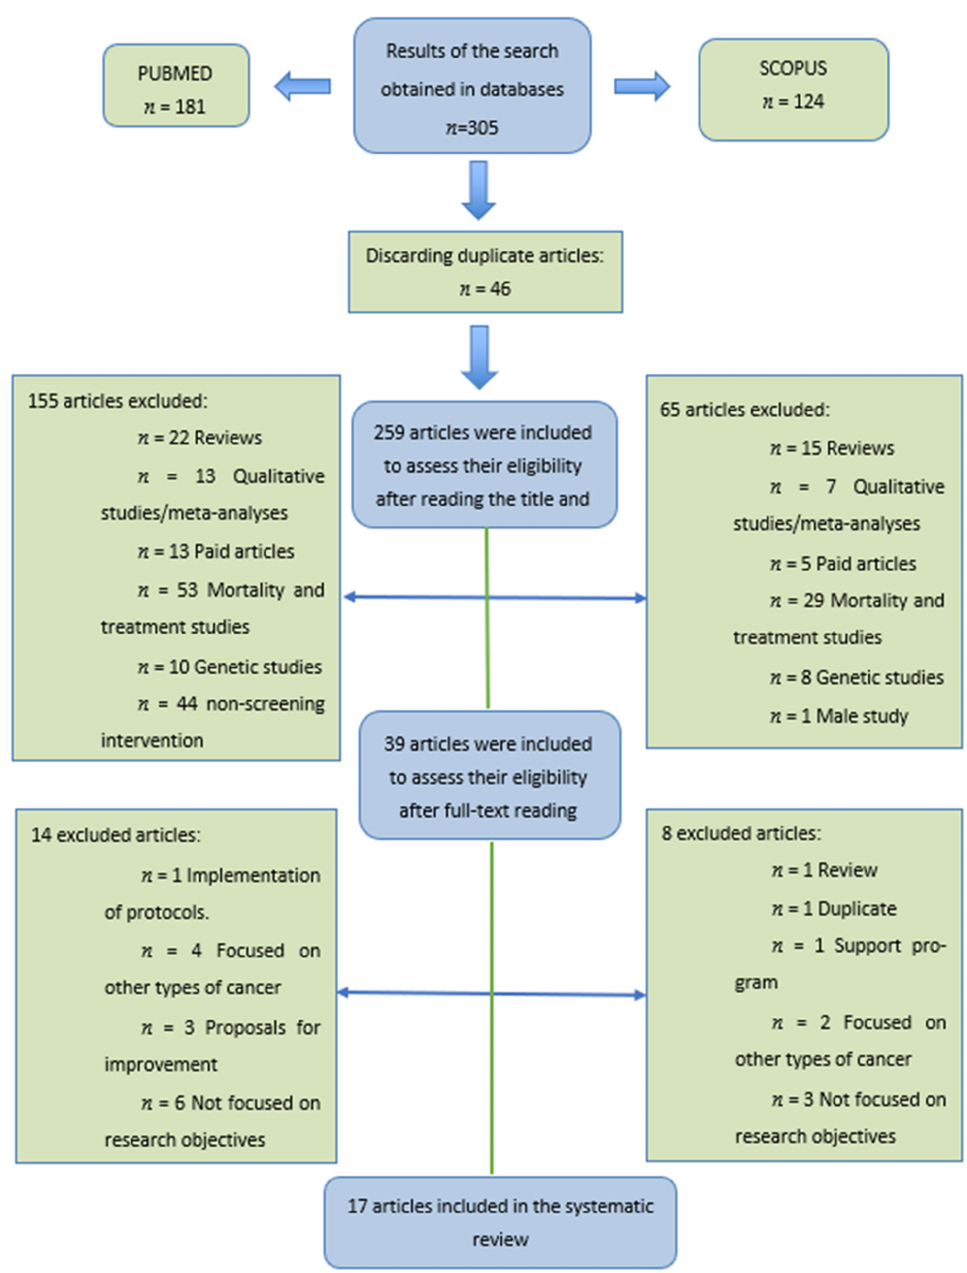
Scheme 1. Flowchart of the article-selection